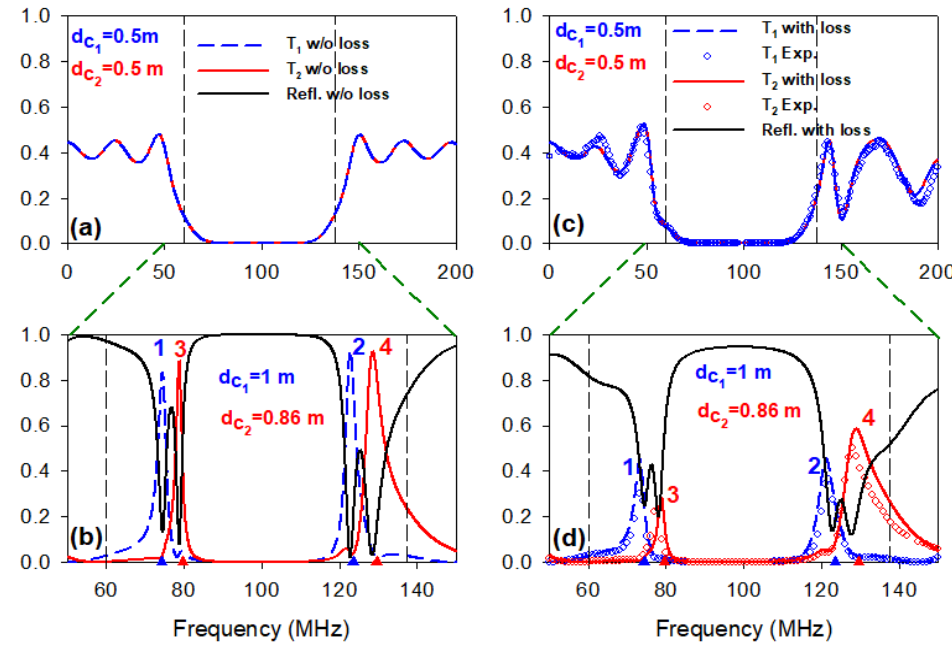
Figure 9. ( a ) Transmission through the two outputs of demultiplexer (Figure 7a) formed by three identical stubs of length d 2 = 0.5 m (without defect) separated by segments of lengths d 1 = 1 m. ( b ) Transmission along the output 1 of the demultiplexer (Figure 7a) which contains = 1 m (blue curves) and along the output 2 of the demultiplexer which contains the the cavity d c 1 = 0.86 m (red curves). Solid lines give the theoretical results in the absence of loss. cavity d c 2 ( c , d ) Experimental verification of the results in ( a , b ) respectively. Blue and red solid lines and open circles give, respectively, the theoretical results in the presence of loss and the experimental ones. The black curves in ( b , d ) correspond to the theoretical